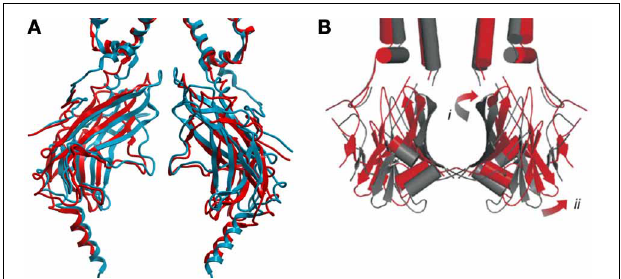
FIGURE 3 | (A) Comparison of GIRK2 in the closed PIP 2 bound conformation (PDB: 3SYA, blue) and in the maximally open (R201A) + PIP 2 bound conformation (PDB: 3SYQ, red). (B) Comparison of the KirBac1.1 channel cytoplasmic domain (subunits A and C) in the closed (PDB: 1P7B, gray) and predicted “open” (red) conformations. Opening requires outward twisting and tilting of the major β I sheet (i), and outward motion of the minor β II sheet (ii) [adapted from Wang et al. (2012)]. Qualitatively, the movements involved in GIRK2 channel opening appear similar to those predicted for the prokaryotic KirBac1.1